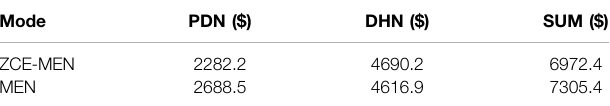
TABLE 4 | Operation costs under ZCE-MEN and traditional MEN.